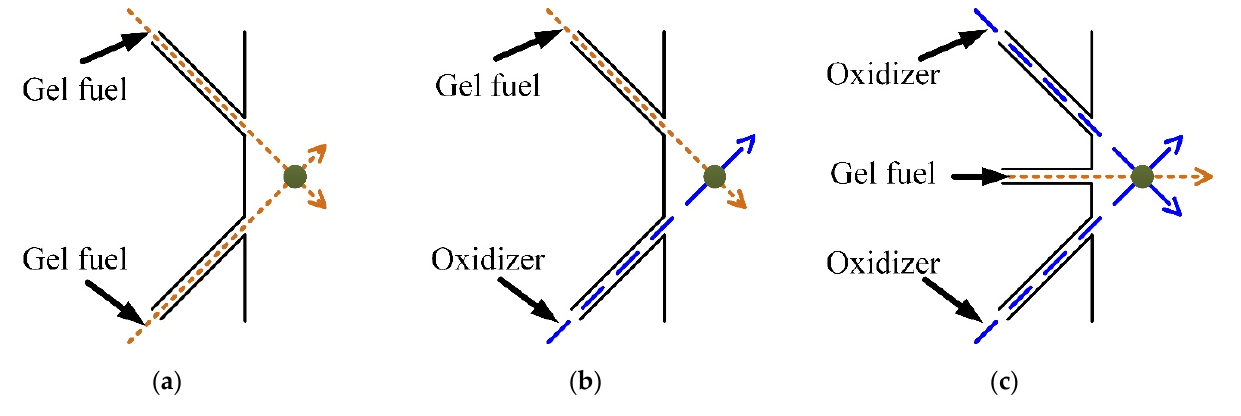
Figure 9. Schematic representation of two-jet ( a , b ) and three-jet ( c ) gel fuel atomization [92,99].